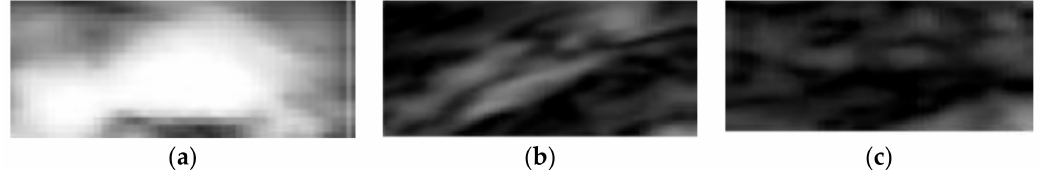
Figure 11. Different tissue types in the plaque area of IVUS images: ( a ) dense calcium, ( b ) necrotic core, and ( c )